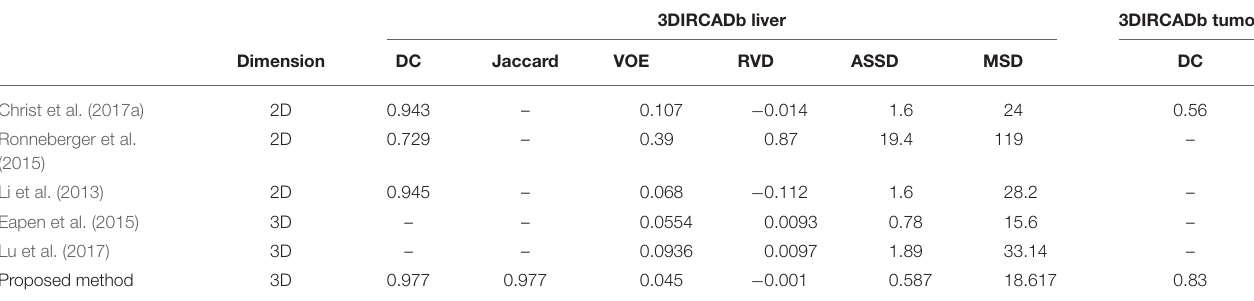
TABLE 6 | Segmentation results compared with other methods on the 3DIRCADb